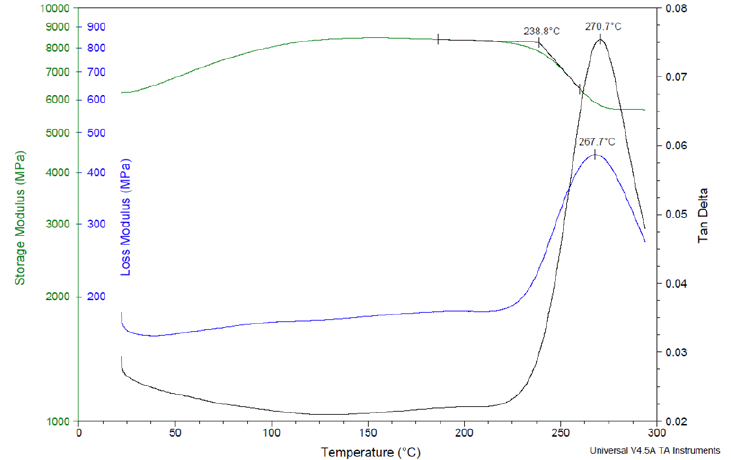
Figure 8. DMA thermogram for Nextel 312/poly(BAF-oda-fu) composite with no post-cure heat